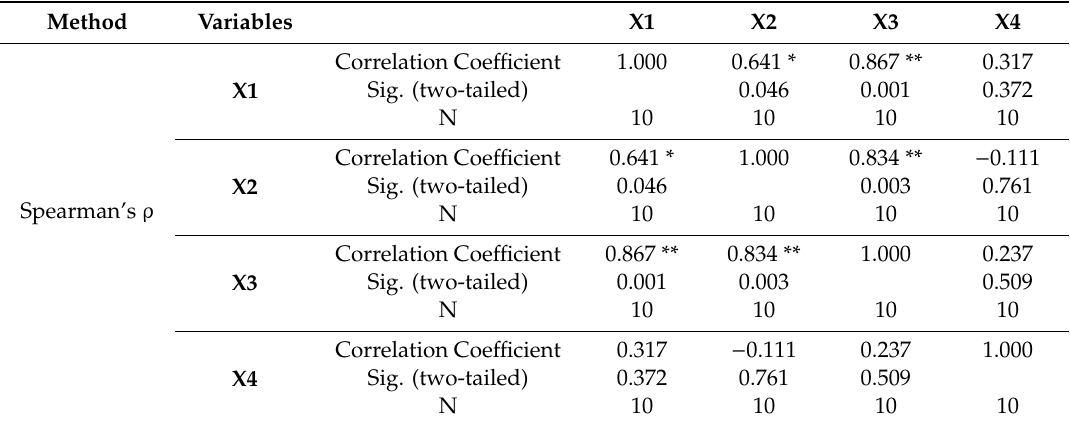
Table 3. Bivariate correlation